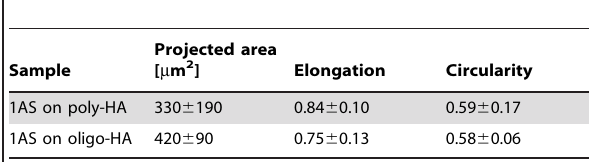
Table 1. Shape descriptors of adhesion